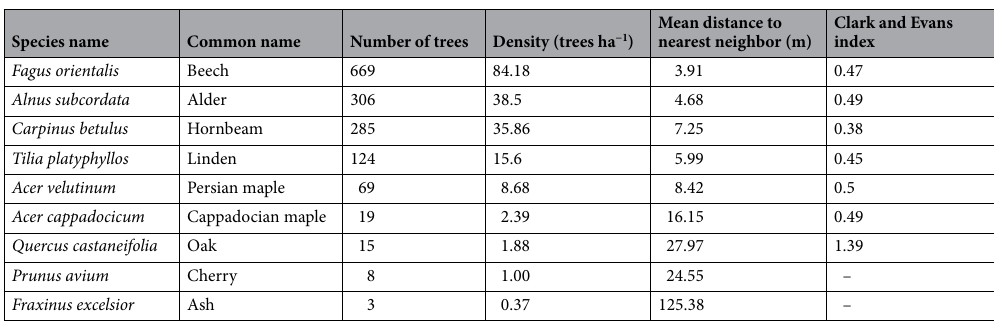
Table 1. Spatial distribution characteristics in the studied